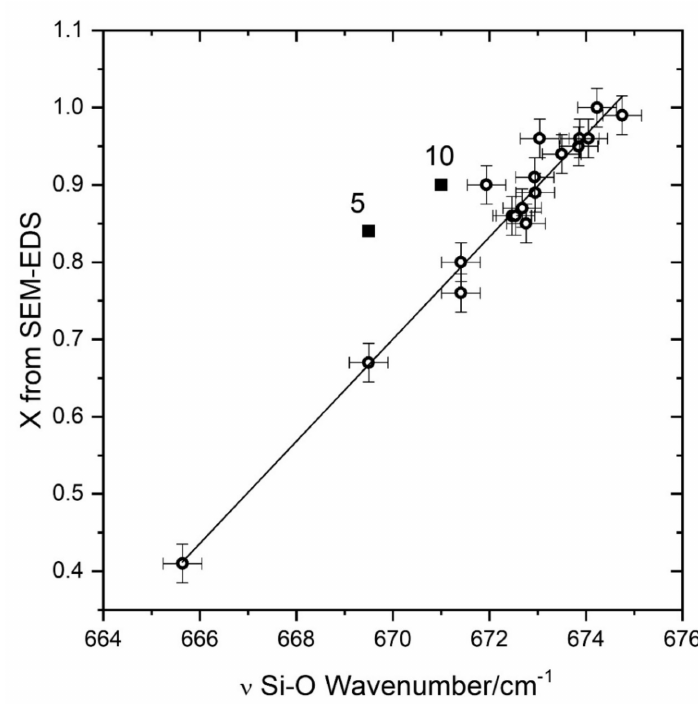
Figure 2. Relation between the wavenumber ν of the A g main Raman peak at low wavenumber and the chemical composition X = Mg / (Mg + Fe 2 + ). The straight line represents the result of the linear interpolation: X = 0.066 × ( ν − 659.3). The numbered points are the outliers described in the